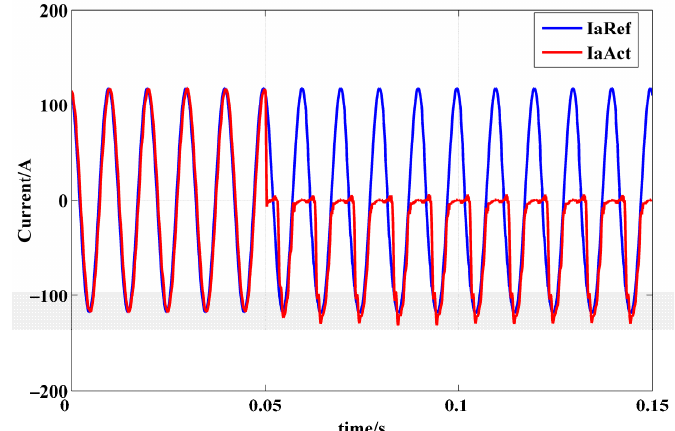
Figure 2. The current of phase A with an open circuit fault in T1 at 1000 rpm/100 Nm.